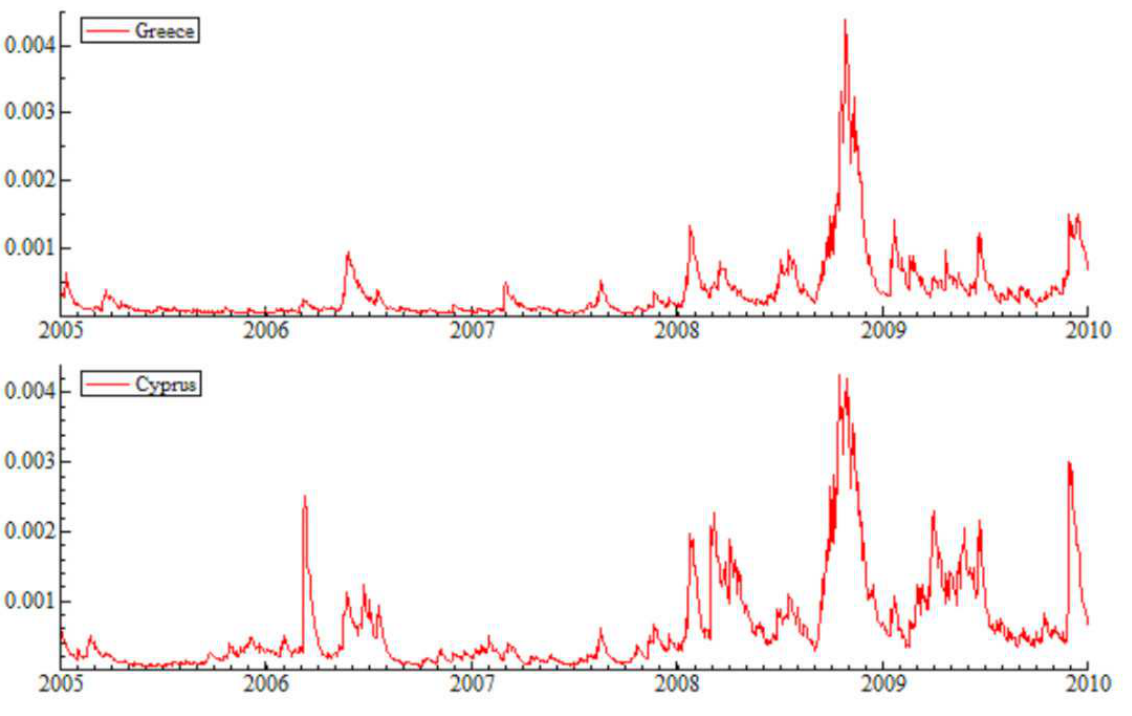
Figure 3. Univariate conditional variances (GFC period)